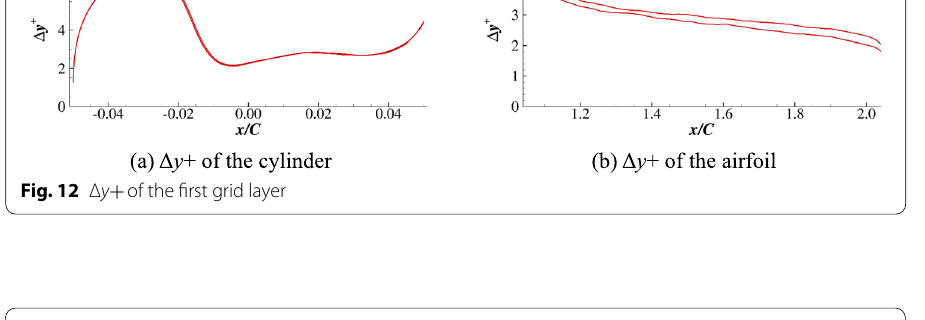
of the first grid layer +